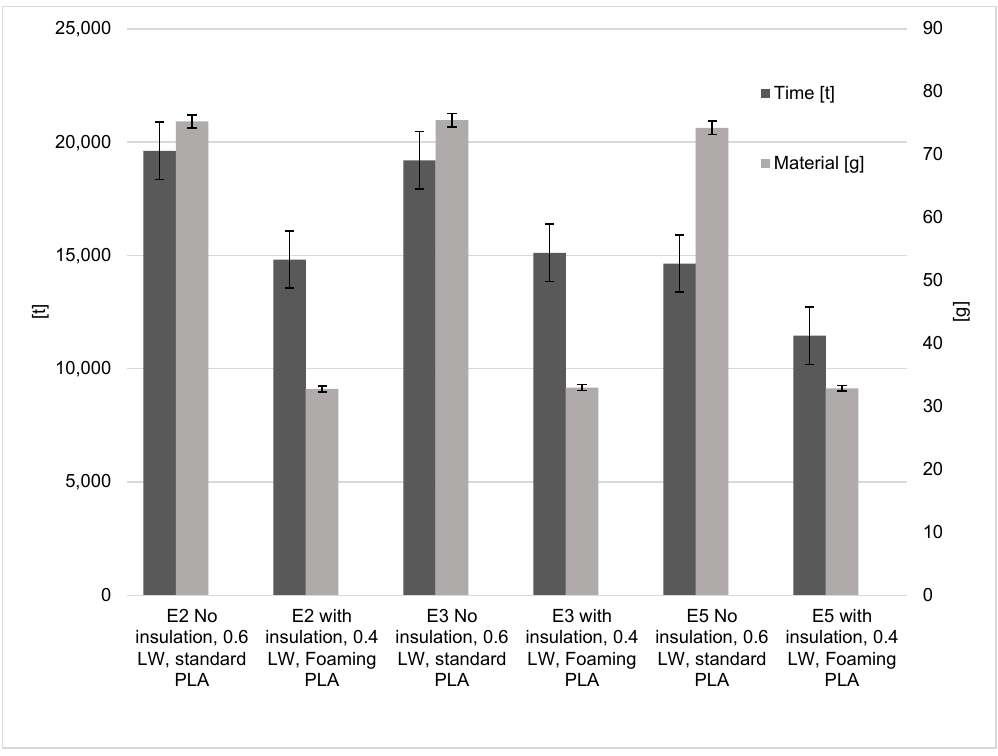
Figure 12. Optimised insulation, line width and foaming PLA influence on material and time re ‐ sults.